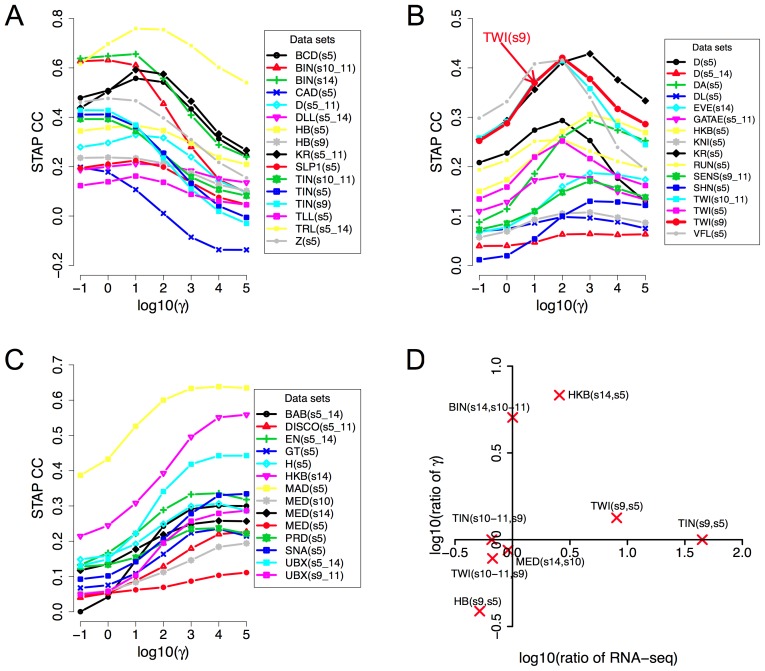
Influence of TF concentration to TF-DNA occupancy.
A–C: Dependence of correlation coefficient (CC) between ChIP scores and STAP scores (y-axis) on the TF-specific parameter γ that was varied in the range 10−1 and 105 (x-axis). All 45 data sets are shown, split into three panels corresponding to cases where the optimal γ was in the range 10−1 to 101 (A), 102 to 103 (B), or 104 to 105 (C). The parameter γ in the STAP model reflects the product of the equilibrium constant of the consensus site and the TF's concentration. D. Changes in the trained value of the TF-specific parameter γ from one stage to another are consistent with changes in RNA-SEQ-based expression level of the TF. Given a TF for which we have ChIP data from two different developmental stages, the ratio of the trained γ values reflects the ratio of TF concentration in those two stages, as per the model. This ratio is plotted against the ratio of RNA-SEQ levels of the TF's gene from those two developmental stages. All points are in the first or third quadrants suggesting that the trained γ values are consistent with expression data. Each point is labeled by the profiled TF's name and the two corresponding developmental stages.